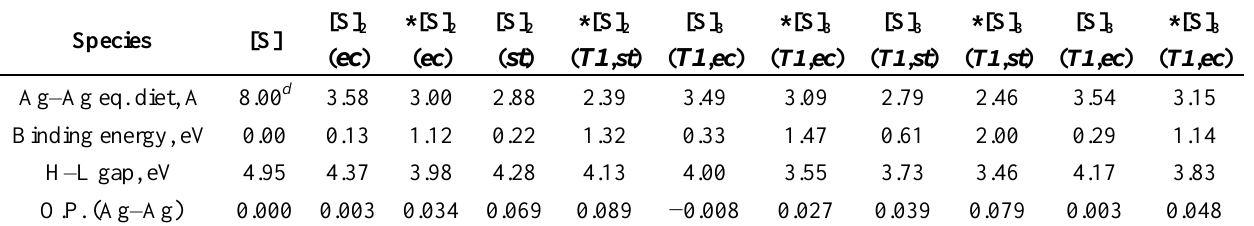
Table 1. Summary of the Results of Extended Hückel Calculations for the Ground and Excited States of Oligomeric Species of Dicyanoargentate(I). (Adapted with permission from [31]. Copyright 1998 American Chemical